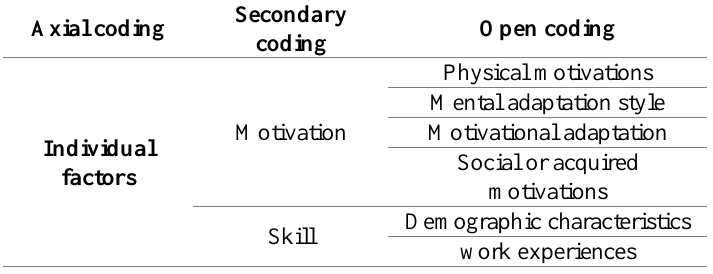
Table 4: Qualitative data coding (intervening conditions)